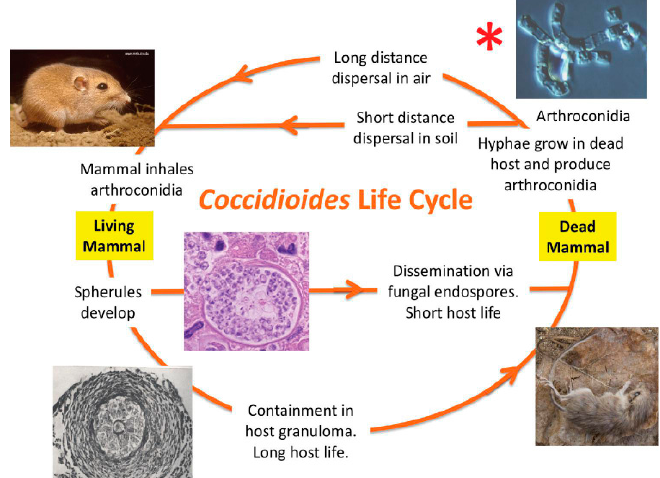
Figure 7. The saprobic (mycelia and arthroconidia) and parasitic (spherule and endospore) life cycle. The figure is from [65]. ( A ), mycelia growing in the soil and differentiating into spherules in animals. ( B ), Endozoan-based life cycle of Coccidioides species. Beginning at the asterisk (*), arthroconidia travel from the hyphae that produced them short distances among small mammals in burrows, or longer distances above ground, to infect other animals. The arthroconidia convert to spherules and are either controlled by the immune reaction or develop endospores, which disseminate to produce grave disease. The infected animal dies, either from disseminated coccidioidomycosis or from other causes and, in either case, living Coccidioides present in the animal, now freed from the host immune system and living at lower temperatures, convert to hyphae. The hyphae grow through the dead animal and then produce abundant arthroconidia, which initiate a new cycle of life for the fungus.